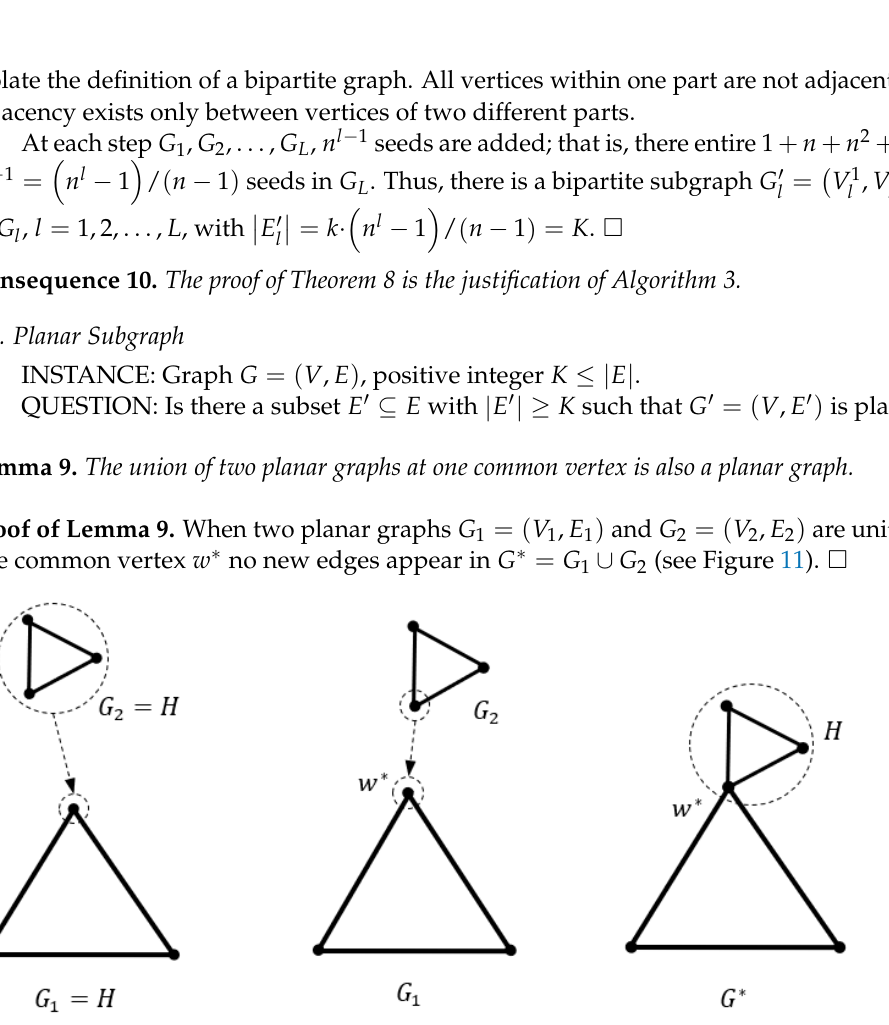
Figure 11. Operation of replacing a vertex with a seed or union of a graph G 1 and a seed H in one